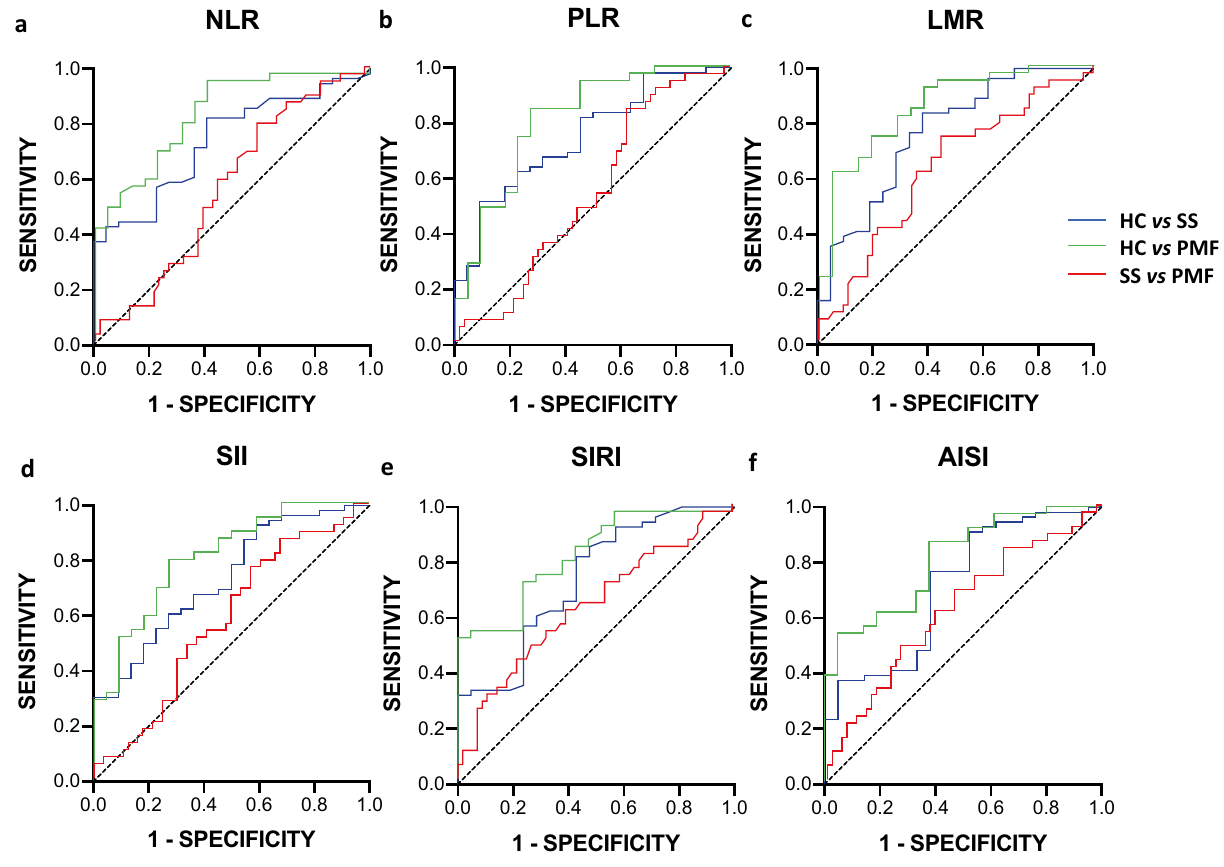
Figure 3. ROC curves using systemic inflammation indices for predictive ES silicosis status between studied groups. ( a ) NLR (neutrophil/lymphocyte ratio), ( b ) PLR (platelet/lymphocyte ratio), ( c ) LMR (lymphocyte/